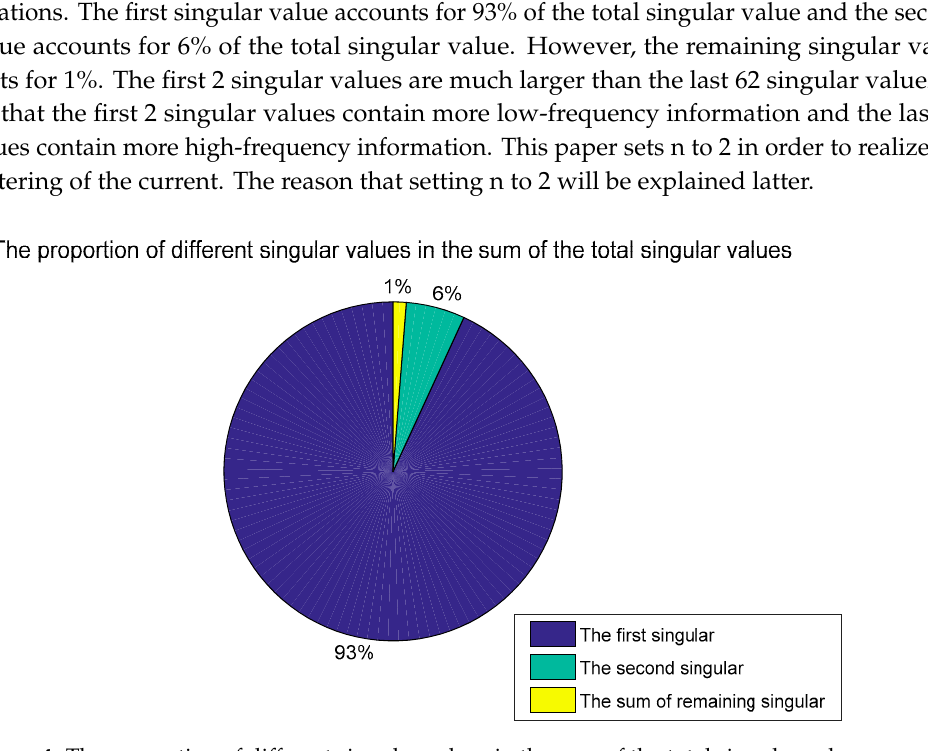
ff erent singular values in the sum of the total singular Figure 4. The proportion of different singular values in the sum of the total singular value. Figure 4. The proportion of di